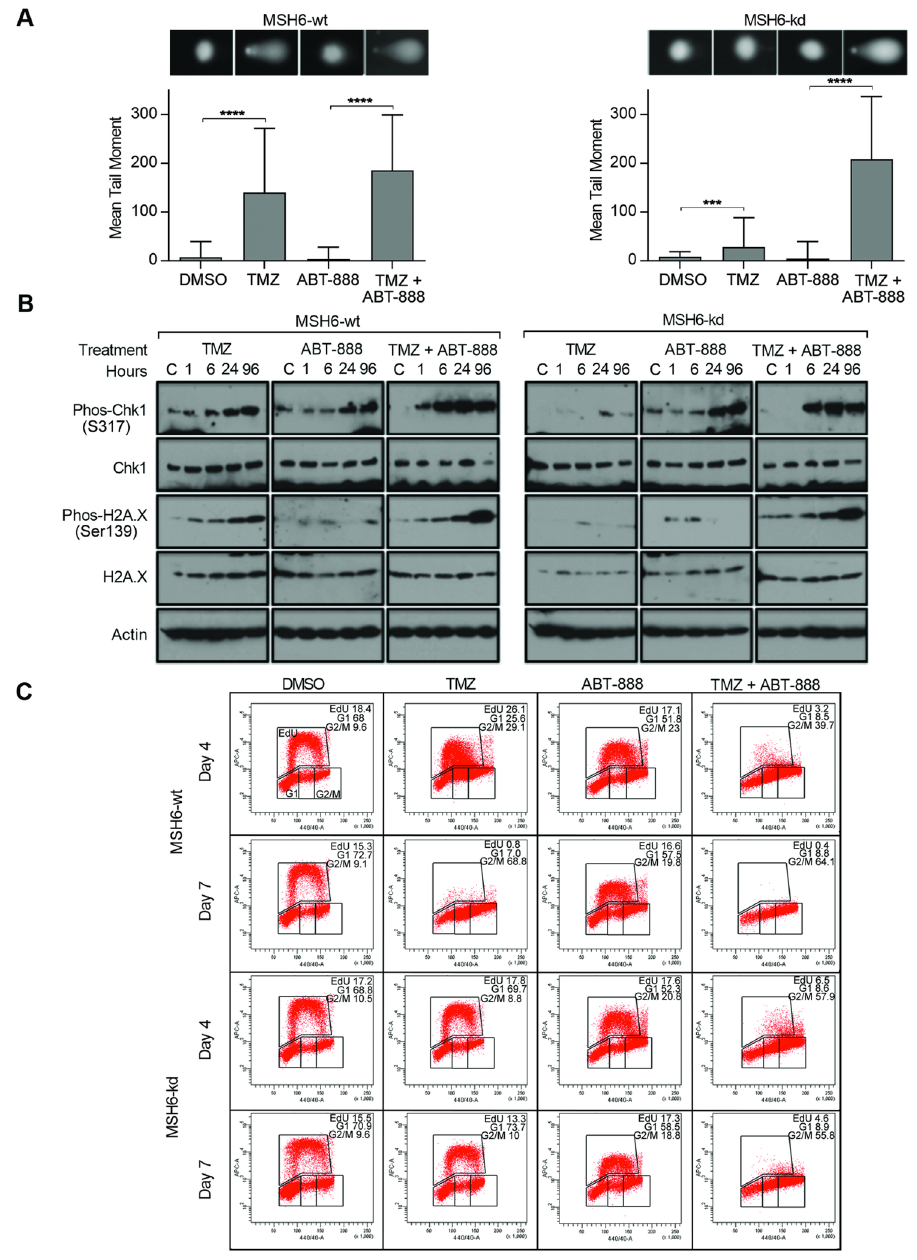
Fig 6. TMZ plus ABT-888 restores DNA breaks, G2/M checkpoint activation, and synthesis arrest in MSH6 mutant lines. (A) Alkaline comet assay representing the mean tail moments of 50 samples grown in suspension and treated with DMSO, TMZ (100 μM), ABT-888 (100 μM), or TMZ (100 μM) and ABT-888 (100 μM). Samples were stained with SYBR green and analyzed by epiflourescence microscopy; representative images are displayed. (B) Lysates taken from MSH6-wt and MSH6-kd cells were treated with DMSO, TMZ (100 μM), ABT-888 (100 μM), or TMZ (100 μM) and ABT-888 (100 μM) and a control sample collected immediately previous to treatment (Control = C), or 1h, 6h, 1d, and 3d after drug exposure. Western blotting was performed for total and phos-CHK1, total and phos-H2A. X, and actin (controls). (C) MSH6-wt and MSH6-kd cells were grown in suspension and exposed to DMSO, TMZ (100 μ M), ABT-888 (100 μ M), or TMZ (100 μ M) and ABT-888 (100 μ M). At days 4 and 7 after treatment cells were stained with EdU and analyzed on the BD LSRII flow cytometer.